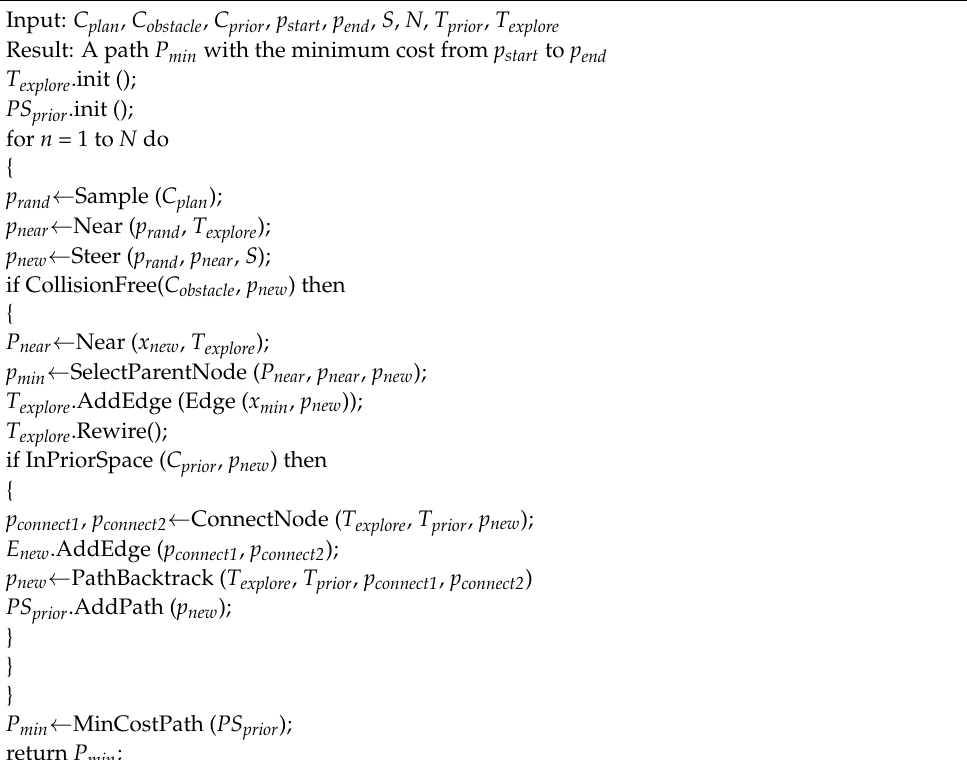
Algorithm 1 The static rapidly exploring random tree star (S-RRT*)